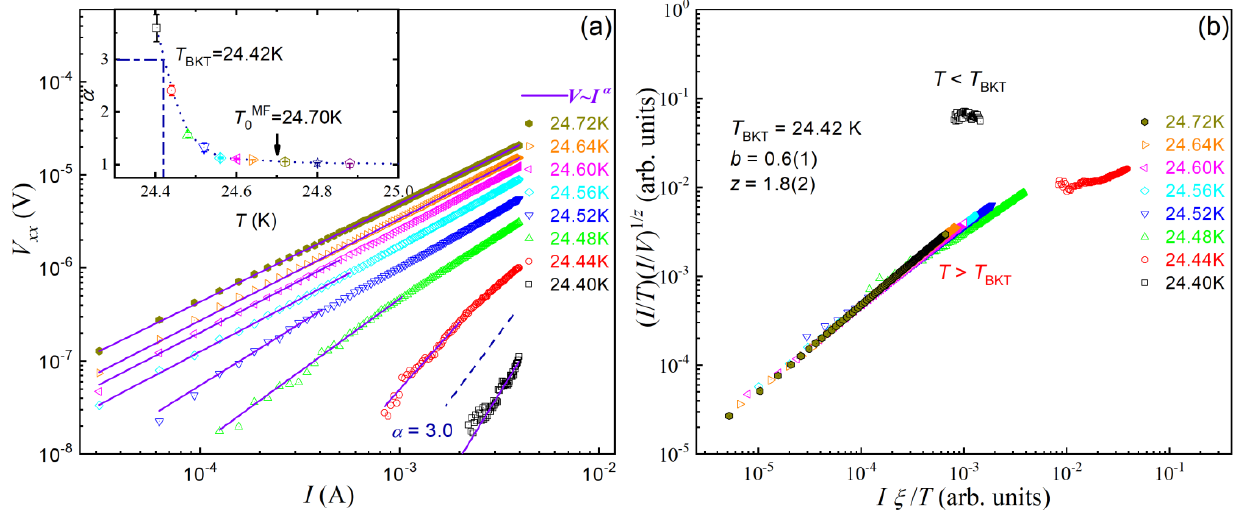
Figure 2. ( a ) A log–log plot of voltage-current characteristics of Ba(Fe 0.914 Co 0.086 ) 2 As 2 crystal at temperatures spanning the critical region from 24.40 K to 24.72 K. The inset shows temperature dependence of fitted by V ∝ I α with the low-current data. ( b ) Dynamic scaling of all the I − V data in ( a ) according to Equation ( 2 ) in the text.